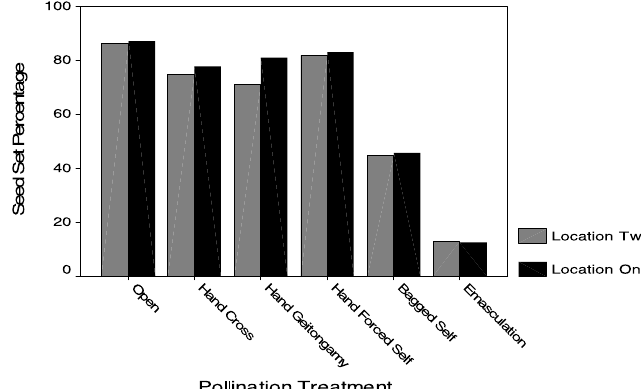
Fig. 4 - Nigella sativa seed set percentage upon pollination treatments in both locations, season two.